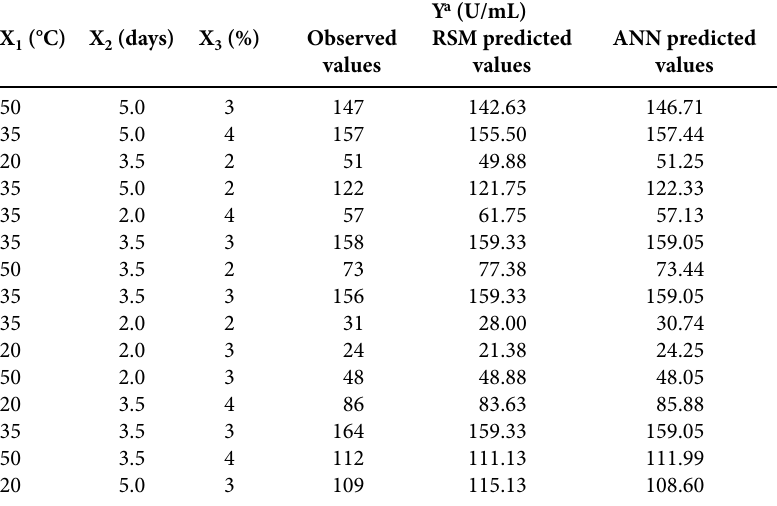
Table 1. Experimental design used in RSM and ANN studies with the values of selected inde- pendent variables and the corresponding observed and predicted responses (Y). Y a